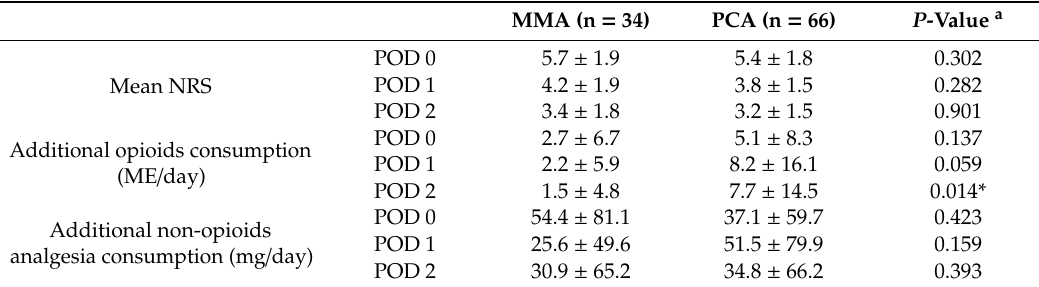
Table 3. Postoperative outcomes.